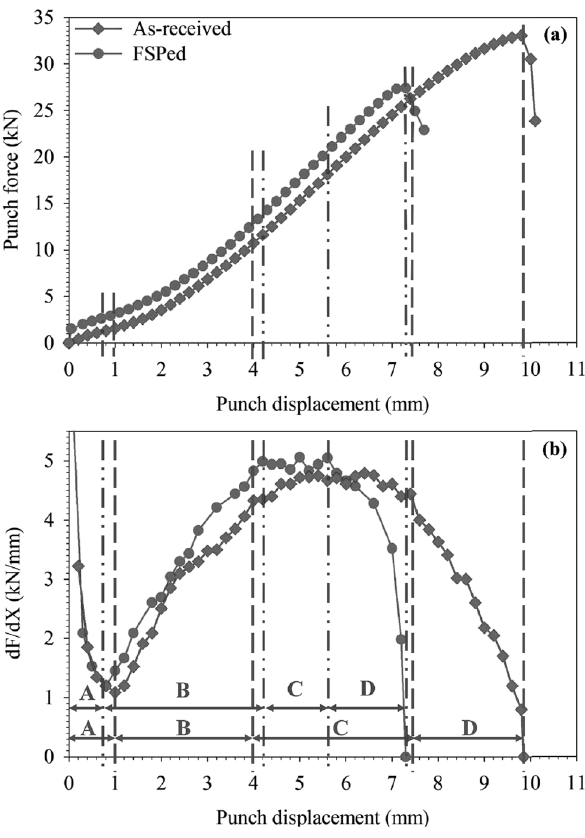
Figure 4: ( a ) Punch displacement ( X ) – punch force ( F ) curves and ( b ) d F /d X – X curves and deformation regions of AR and FSPed DP600